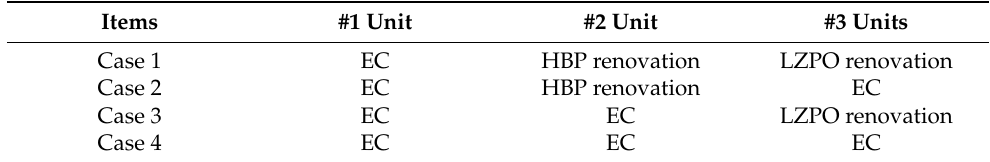
Table 4. Combinations of CHP units.